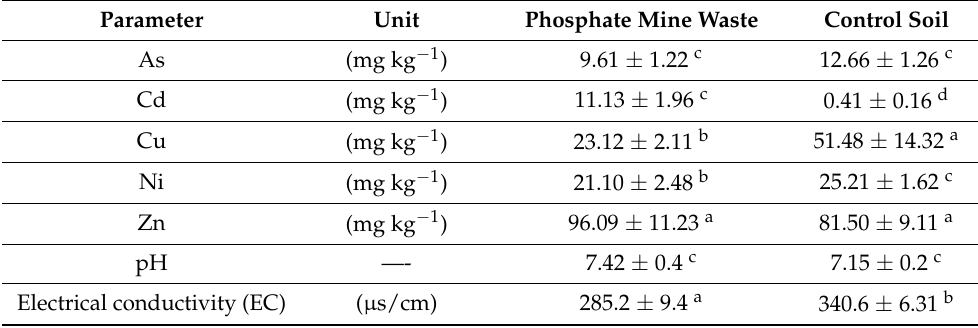
Table 1. Trace elements, major elements, pH, and electric conductivity of the phosphate mine waste. Parameter Unit Phosphate Mine Waste Control Soil As (mg kg − 1